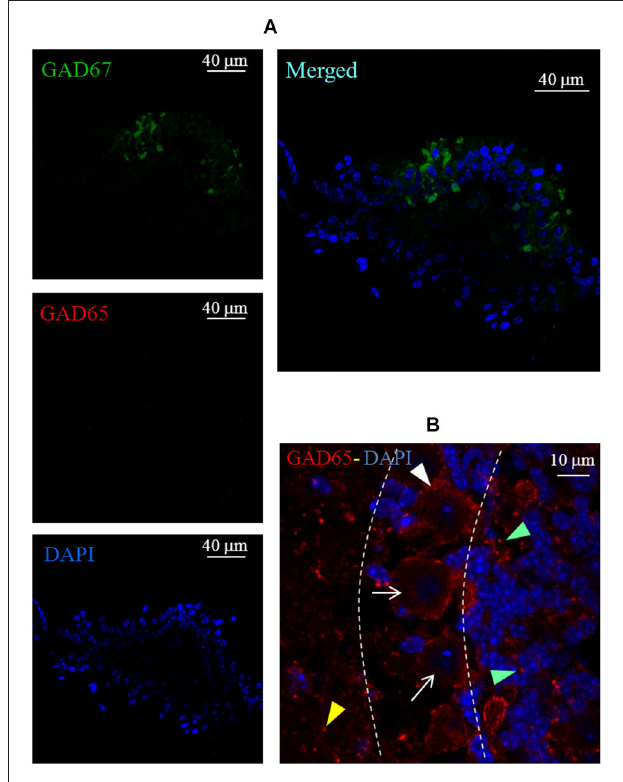
FIGURE 7 | Lack of GAD65 expression in the mouse crista. (A) Photomicrographs of a crista transverse confocal section showing the expression of GAD67 (green), GAD65 (red), cell nuclei (blue; DAPI), and the merged image. Note the absence of GAD65 immunofluorescence. (B) Photomicrograph of a confocal section of a mouse cerebellum slice taken as positive control for GAD65 antibody labeling (red). Note the weak and diffuse immunofluorescence for GAD65 inside Purkinje cells (arrows) and immunofluorescent spots labeling around Purkinje cells (white arrowhead), in the molecular layer (yellow arrowhead) and in the granular layer (green arrowheads). Dashed lines indicate the bounders among the three